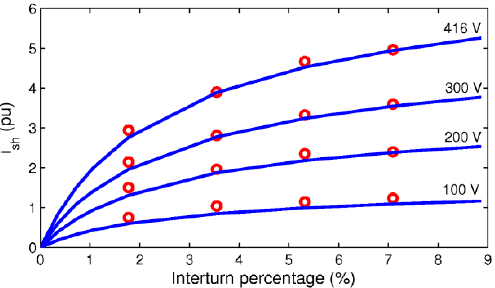
Figure 13. The fault current in the shorted-turns vs. the fraction of shorted-turns with different supply voltages. Simulation results (lines) and experimental results (circles).